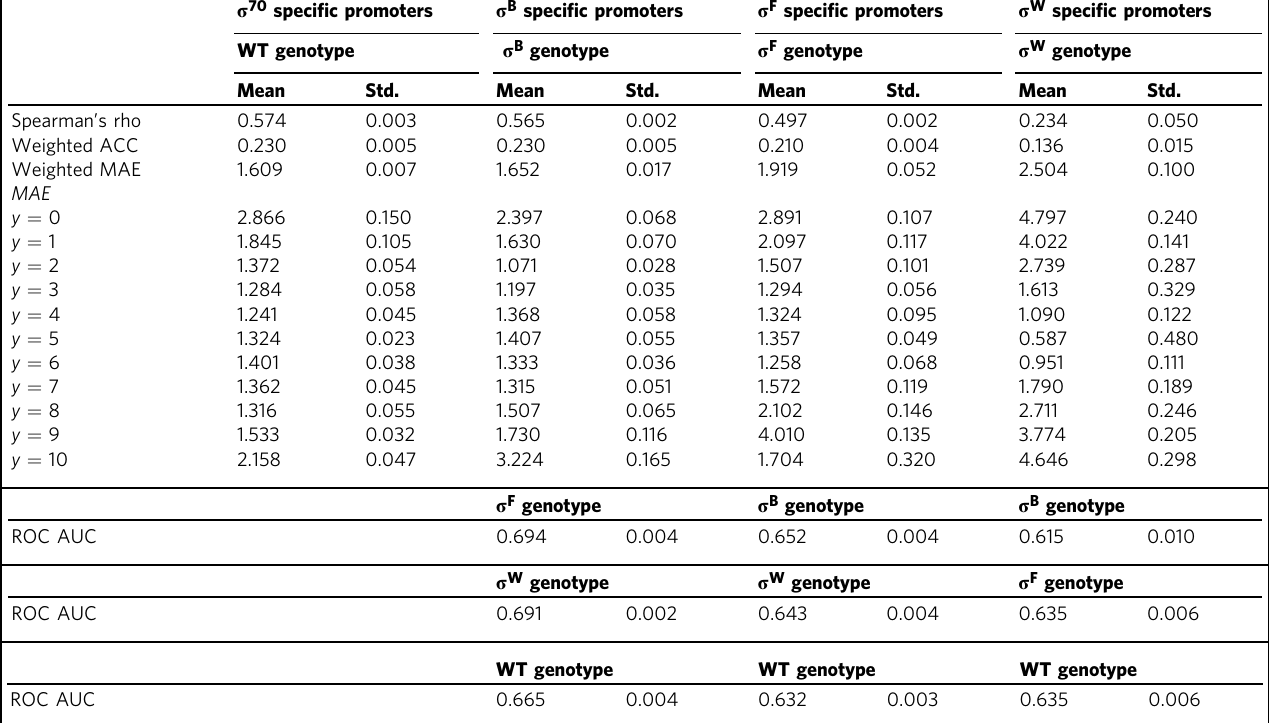
Table 1 Performance metrics of the models on the test